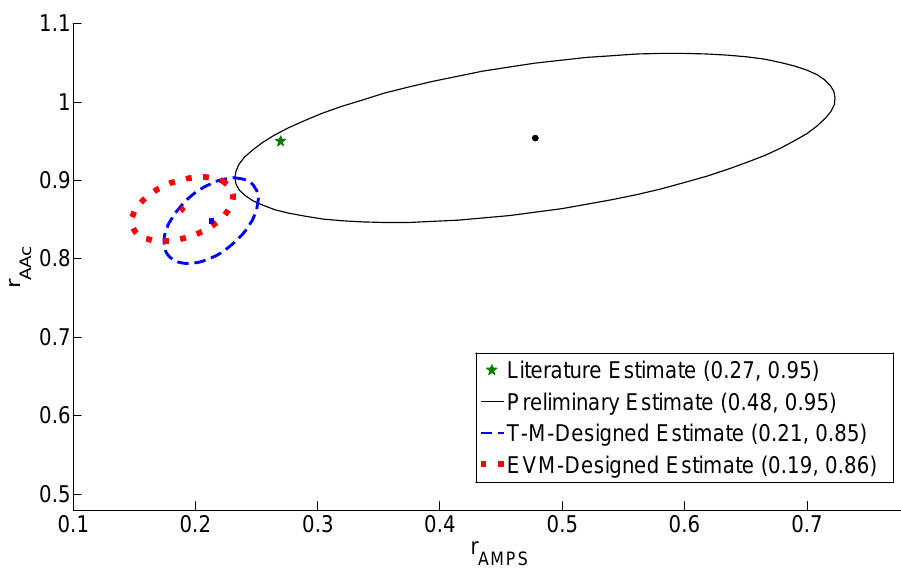
Figure 5. Reactivity ratio estimates for AMPS/AAc